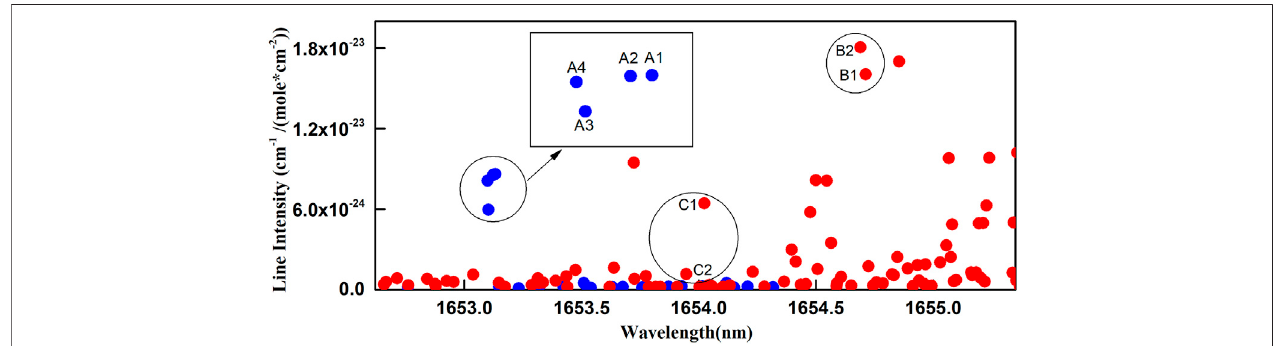
FIGURE1| ThelineintensityplotofCH 4 inthe2v 3 absorption band.Thereddotsarefor 12 CH 4 andthebluedotsarefor 13 CH 4 withinsets indicating